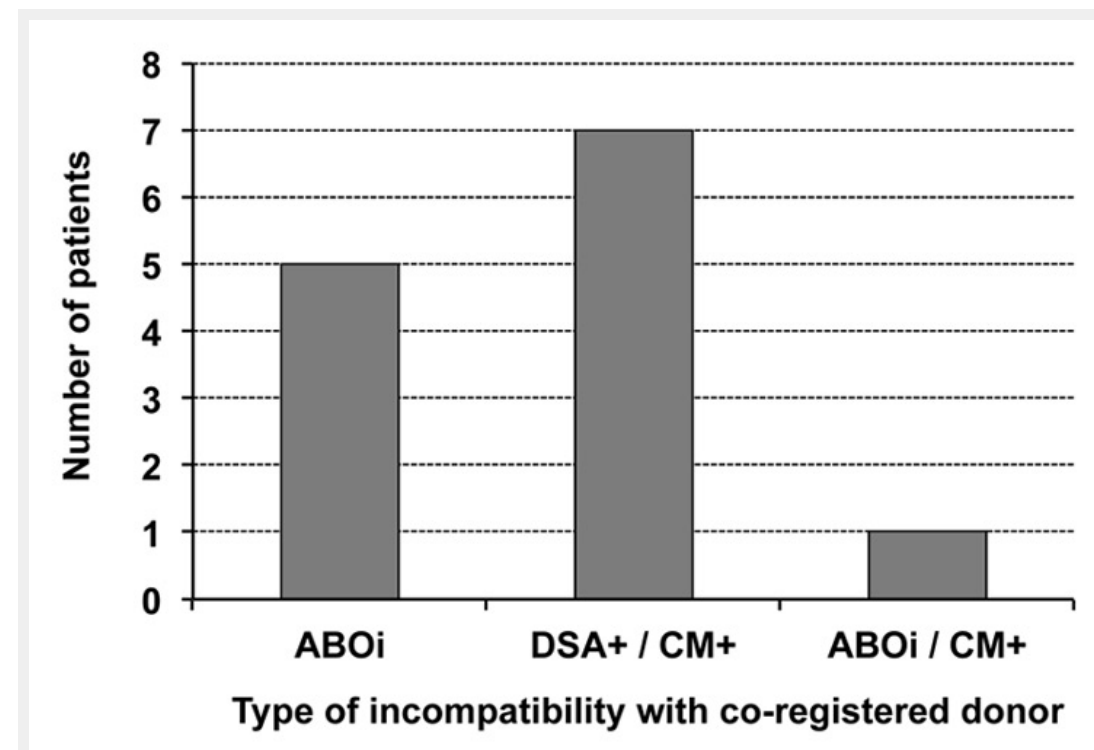
Figure 4 Type of immunological incompatibilities of 13 living donor pairs in Switzerland. ABOi = ABO incompatible; CM+ = positive crossmatch; DSA+ = donor specific